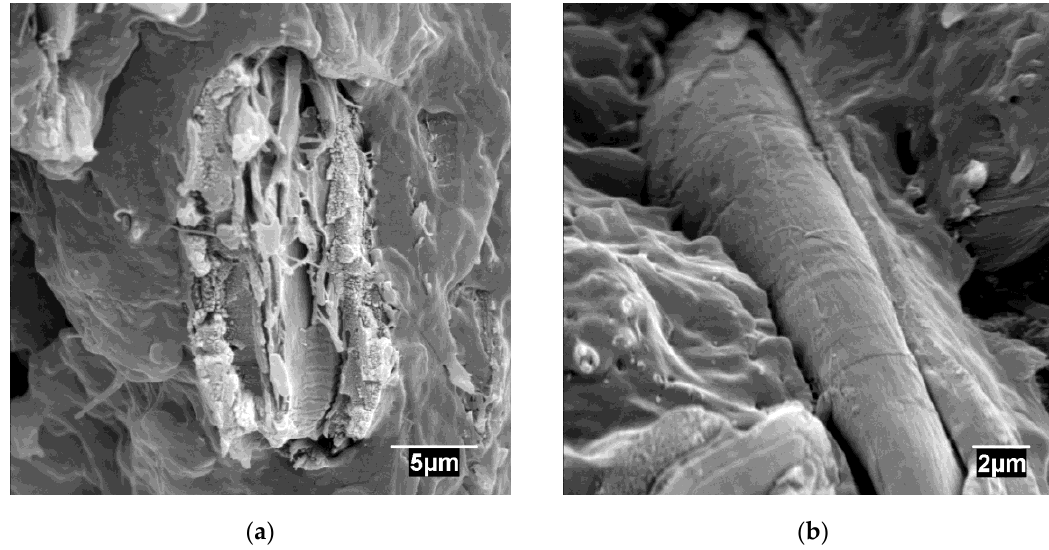
Figure 5. SEM micrographs of coupled PP composites reinforced with 40 wt % at different resolutions: ( a ) Detail of a brook fiber and the absence of voids in the interface; ( b ) Detail of the interface.